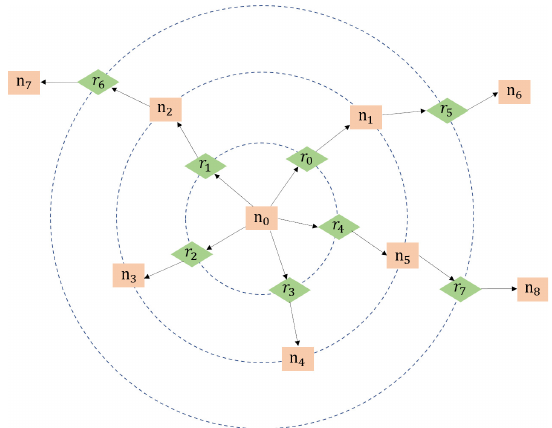
Figure 7. An illustration of multi-scale interaction. Rectangles represent nodes and diamonds represent